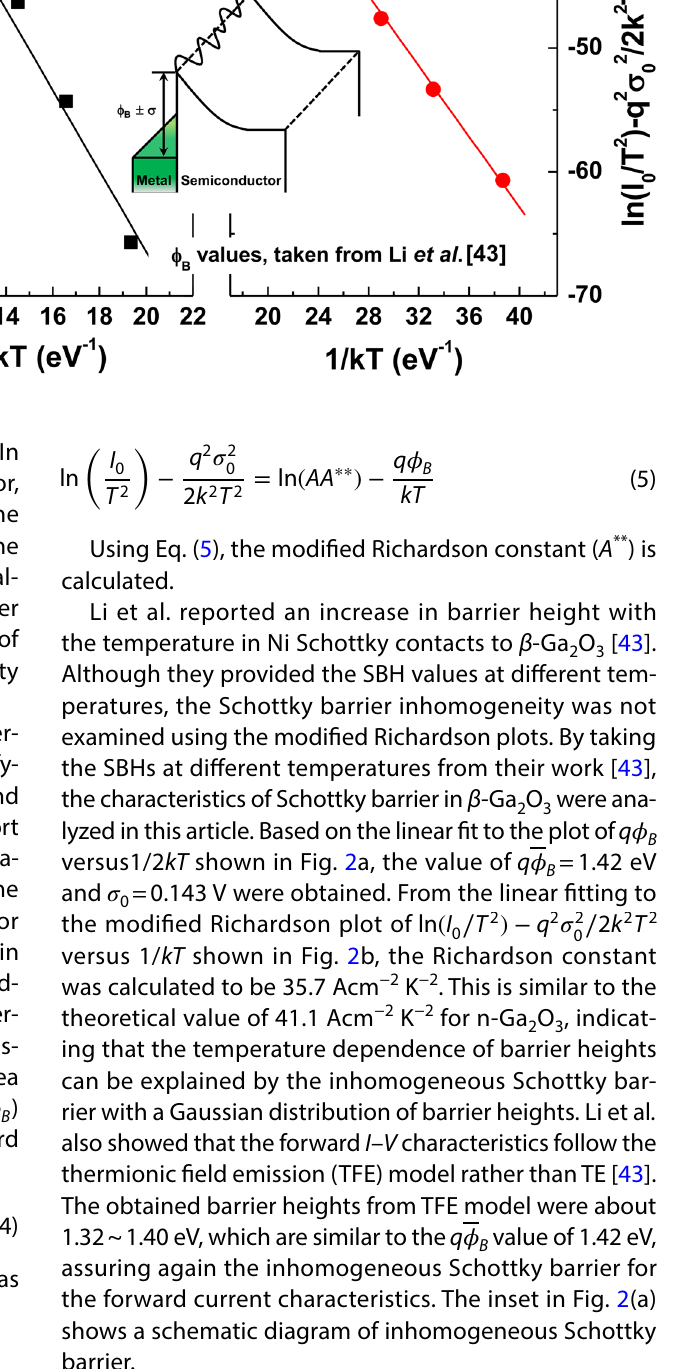
Fig. 2 a Plot of barrier height versus 1/2 kT and b modified Richardson plot. The barrier heights at different tempera- tures were taken from Li et al. [43]. The inset in a shows a schematic band diagram of inhomogeneous Schottky